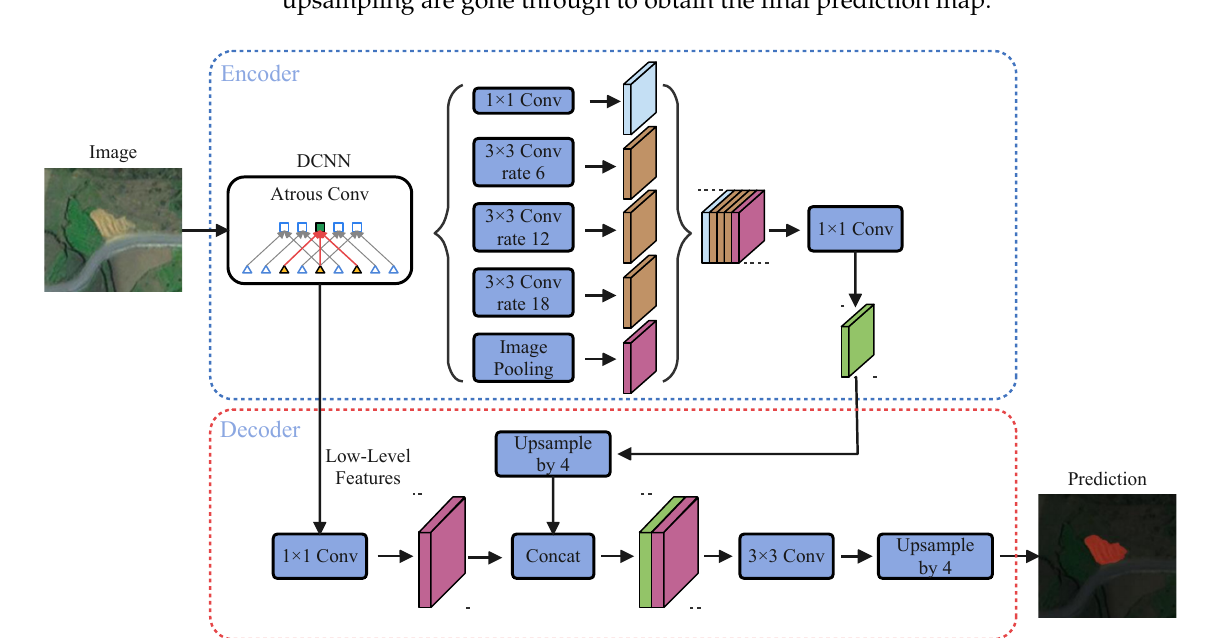
Figure 2. DeepLabv3+ architecture. DCNN stands for deep convolutional neural network, and Atrous Conv stands for atrous convolution. Cyan, orange, pink and green represent the extracted feature layers. The dark blue boxes represent the operations taken on the feature